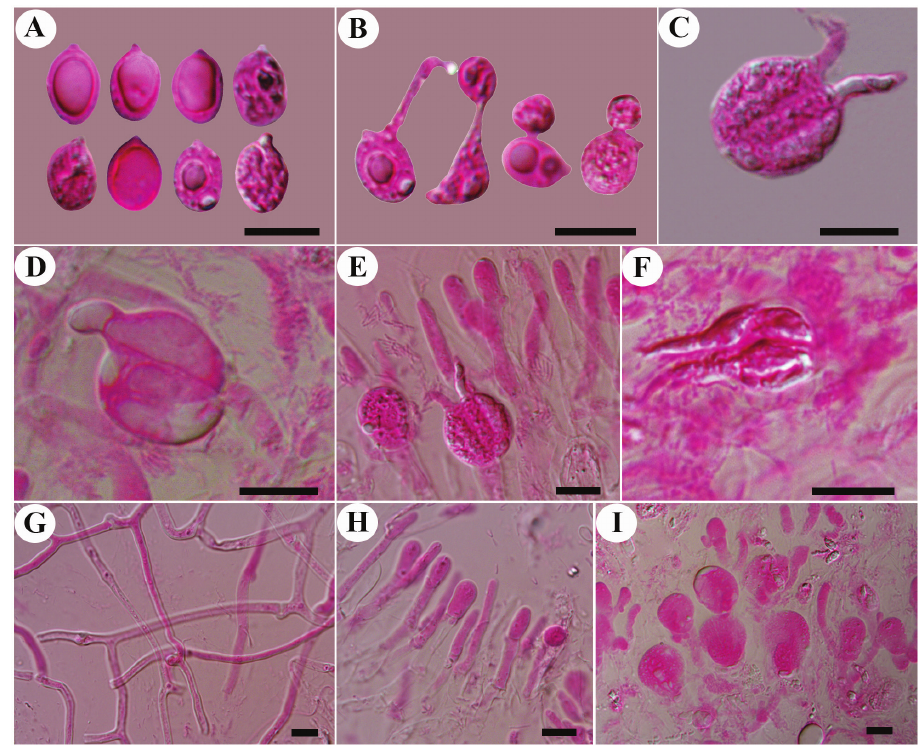
Figure 5. Microscopic structures of Tremella australe (Wu 154) A basidiospores B germination tubes of basidiospores and secondary spores C–F basidia at different stages G hyphae with clamp connections and clamp complexes H hyphidia I a section of hymenium. Scale bars: 10 µm ( A–I